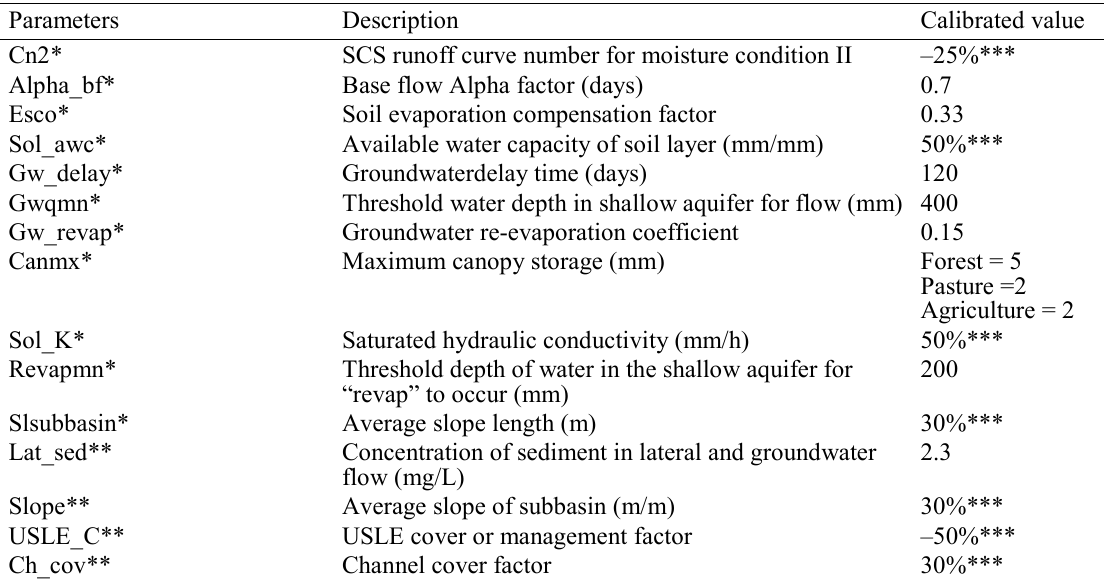
Table 1 Parameters modified for simulation of runoff and sediment, their description and the adopted value.